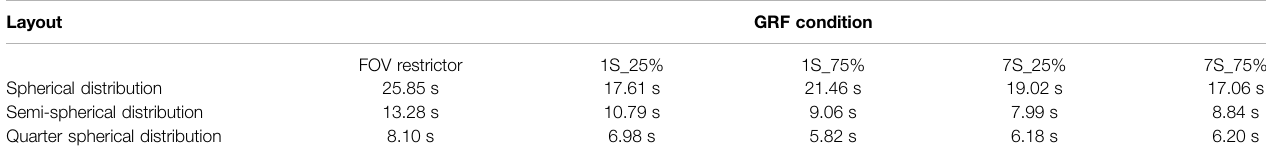
TABLE 1 | Average search time in the formative study. Layout